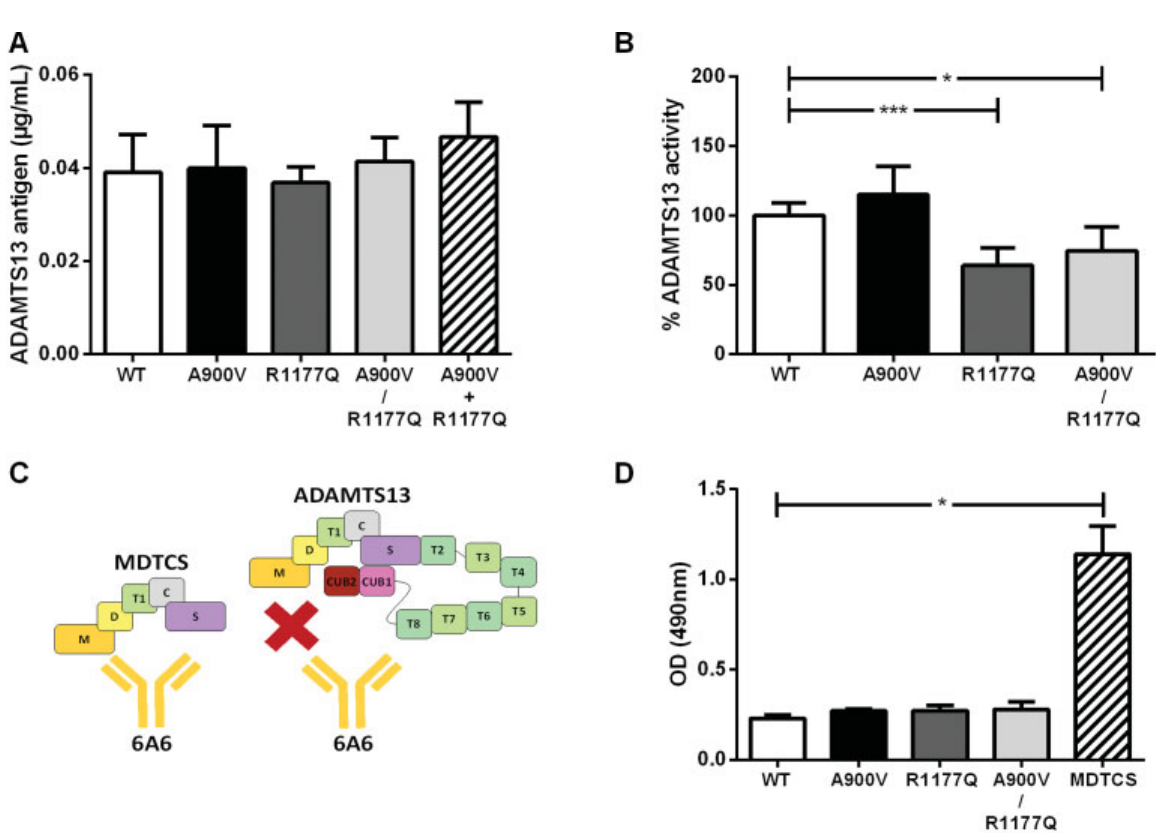
Fig. 2 No effect on ADAMTS13 secretion and conformation, but decreased ADAMS13 activity by p.R1177Q mutation. ( A ) CHO cells were transiently transfected with plasmids pcDNA6.1-ADAMTS13-WT, pcDNA6.1-ADAMTS13-p.A900V, pcDNA6.1-ADAMTS13-p.R1177Q, pcDNA6.1-ADAMTS13-p.A900V/p.R1177Q or pcDNA6.1-ADAMTS13-p.A900V þ pcDNA6.1-ADAMTS13-p.R1177Q, and a pmaxGFP plasmid to determine transfection ef fi ciency. ADAMTS13 antigen levels in the expression medium were determined through ELISA. NHP was used as a reference and set as 1 µg/mL. Kruskal – Wallis compared with WT ( n ¼ 3). ( B ) A FRETS-VWF73 assay was performed to determine activity of WT and p.A900V, p.R1177Q, and p.A900V/R1177Q ADAMTS13 variants. Kruskal – Wallis compared with WT, (cid:4) p ¼ 0.0283, (cid:4)(cid:4) p ¼ 0.0005 ( n ¼ 9 – 14). ( C ) The cryptic epitope of antibody 6A6 in the metalloprotease domain of ADAMTS13 is accessible in the truncated ADAMTS13 variant MDTCS (ADAMTS13 without T2 till CUB domains; left), but not in full length ADAMTS13 (right). ( D ) Conformation of ADAMTS13 variants was studied by adding WT, p.A900V, p.R1177Q, and p.A900V/p.R1177Q ADAMTS13 (6.25nM) to coated 6A6. MDTCS was used as a positive control. Kruskal – Wallis compared with WT, p < 0.05 ( n ¼